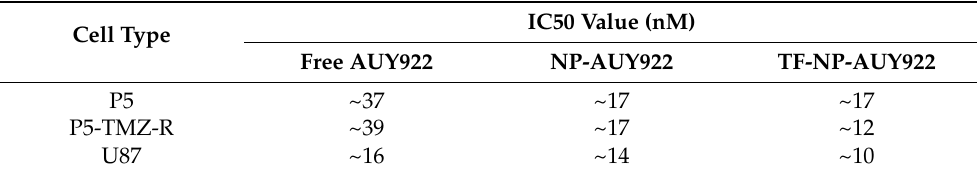
Figure 4. MTT in vitro cytotoxicity results using P5 and P5-TMZ-R cancer cells ( A ) HA-SS-PLGA and PLGA-Cys; ( B ) and ( C ) free AUY922, TF-NP-AUY922, and NP-AUY922, ( D ) free AUY922, TF-NP-AUY922 and NP-AUY922 using U87 brain cancer cells, ( E – G ) representative images of the crystal violet-stained colonies using P5, P5-TMZ-R, and U87 brain cancer cells, respectively. (* p < 0.05, ** p < 0.01, *** p < 0.001). Table 1. The IC50 value for P5, P5-TMZ-R, and U87 brain cancer cells after treated with free AUY922, NP-AUY922, and